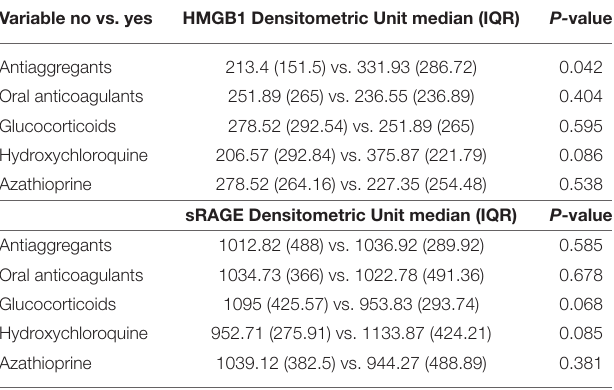
TABLE 2 | Treatment influence on HMGB1 and sRAGE serum levels. Variable no vs. yes